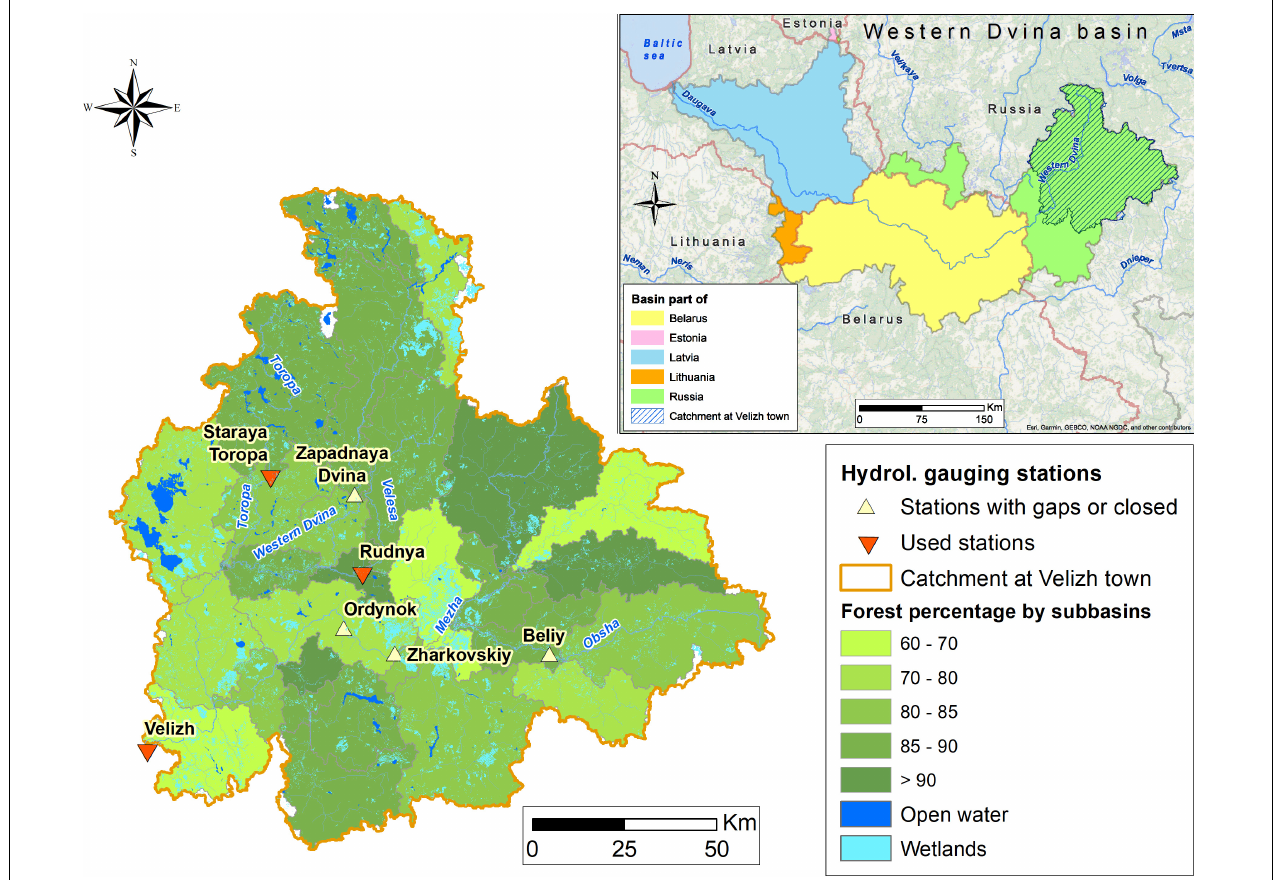
FIGURE 1 | Study area of the Western Dvina catchment (Russian part) with hydrological gaging stations used for model